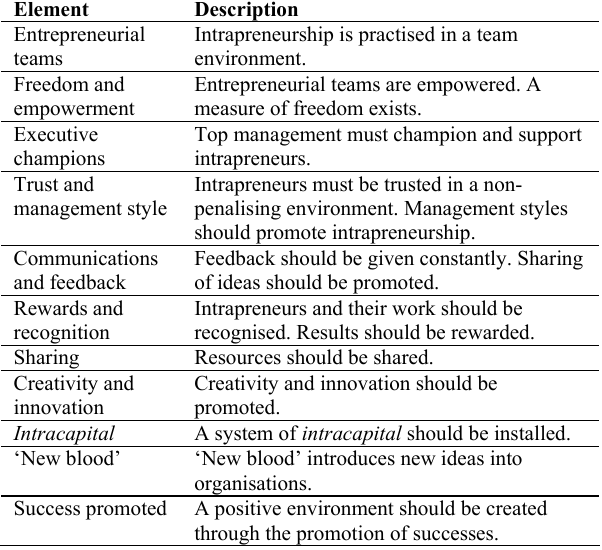
Table 1: Elements of